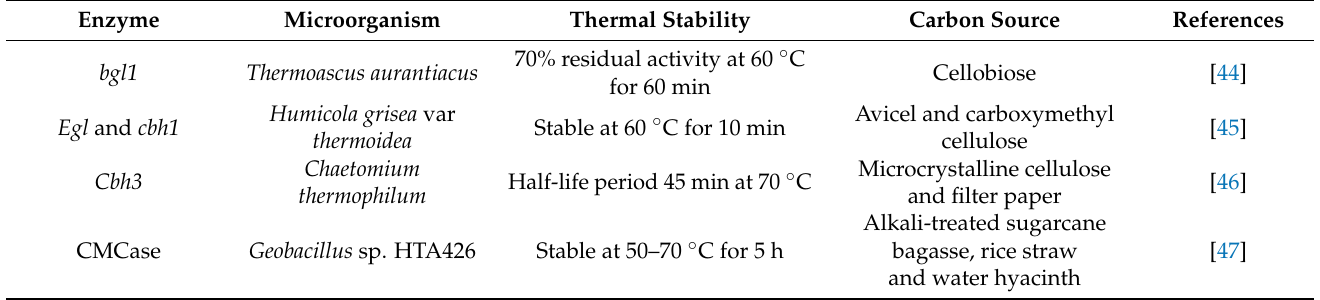
Table 1. Thermostable cellulases of different